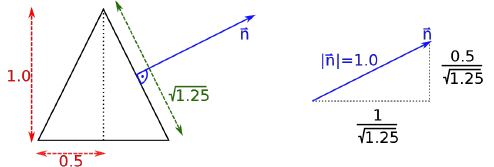
Figure 9: The cone’s normal is perpendicular to its surface and can be calculated from its